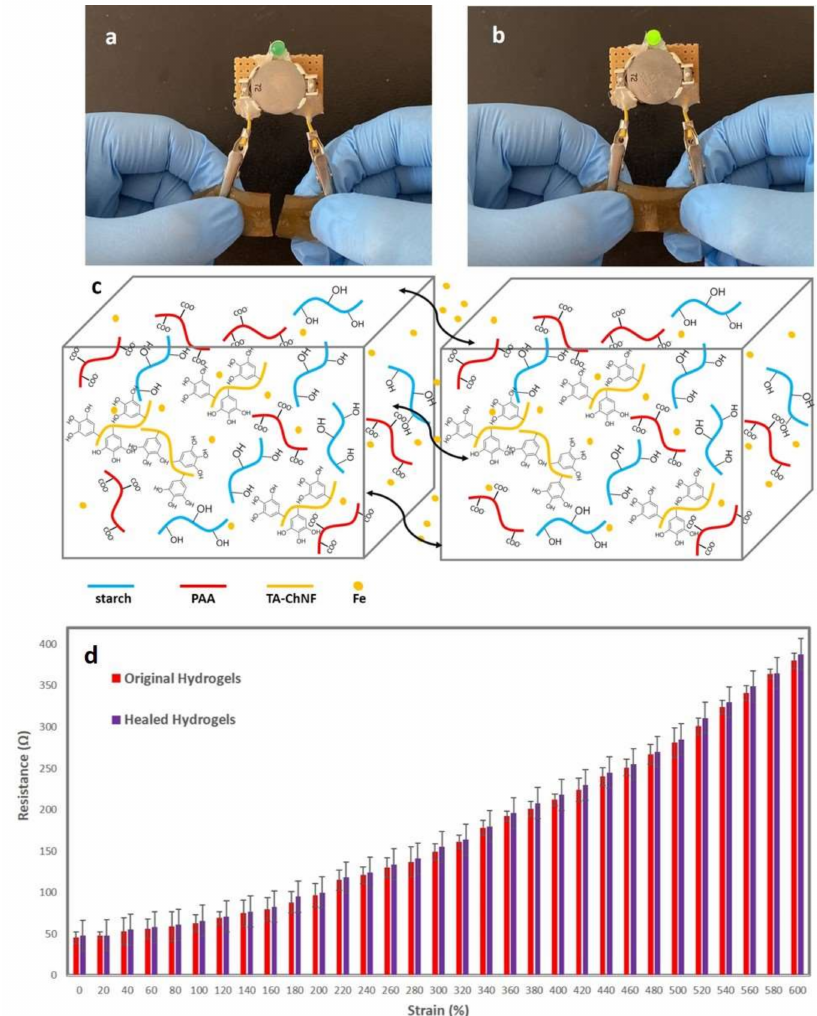
Figure 6. ( a ) Before connecting the cut hydrogel containing 1 wt.% TA-ChNFs; ( b ) after connecting the cut hydrogel with 1 wt.% TA-ChNFs; ( c ) the mechanism of electrical self-healing of the hydrogel and ( d ) the resistance of the hydrogel at di ff erent